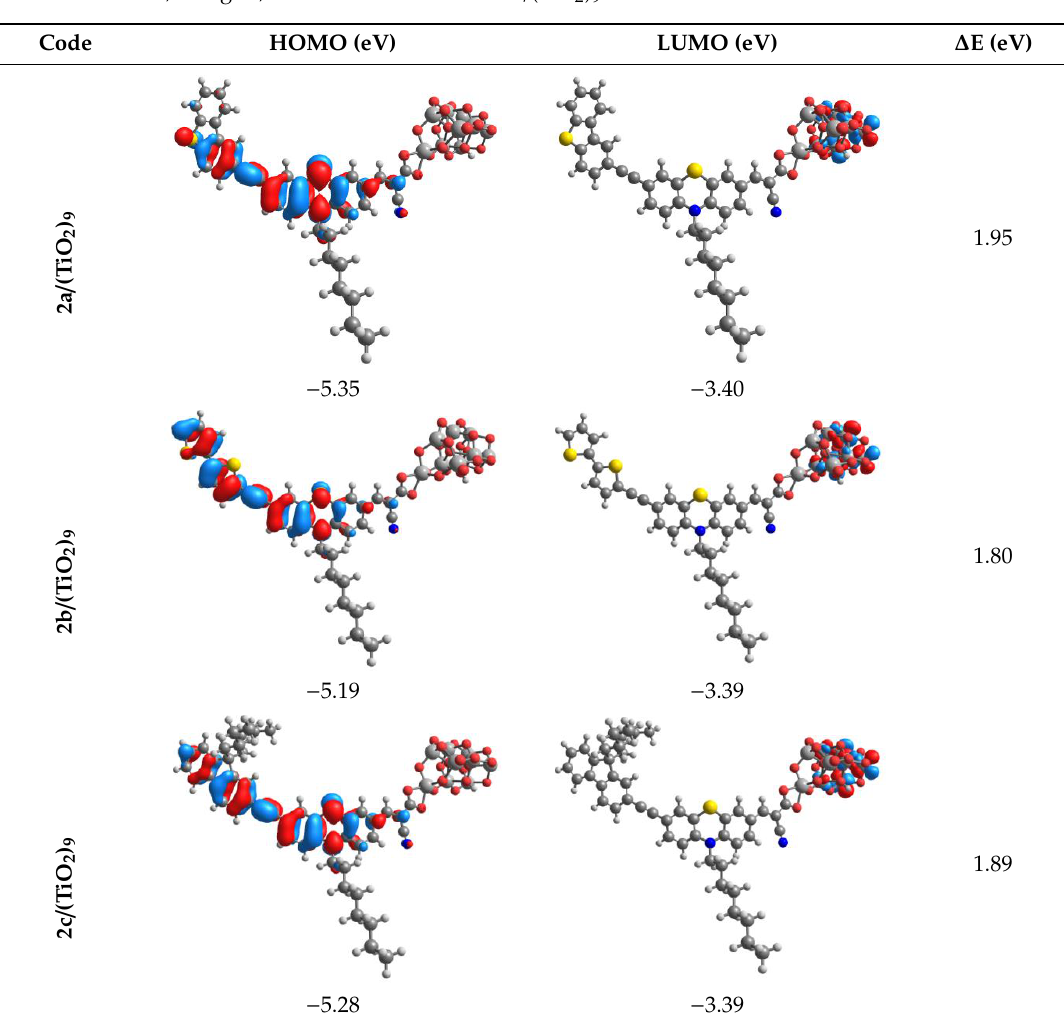
Figure 3. The contributions of particular parts of systems 2a–2c/(TiO 2 ) 9 to the creation of frontier orbitals.